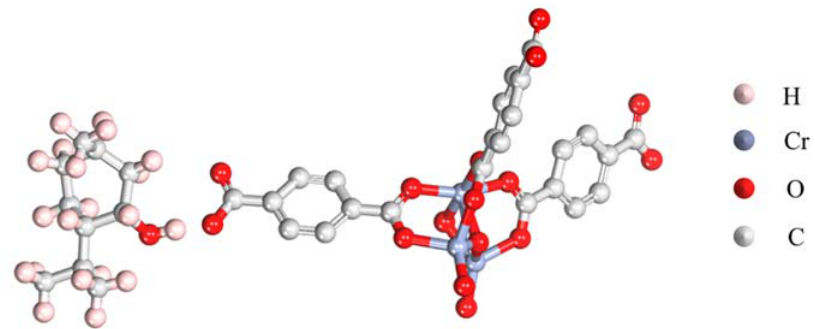
Figure 2. Optimized configuration showing the adsorption of LM and MIL ‐ 101 (Cr).